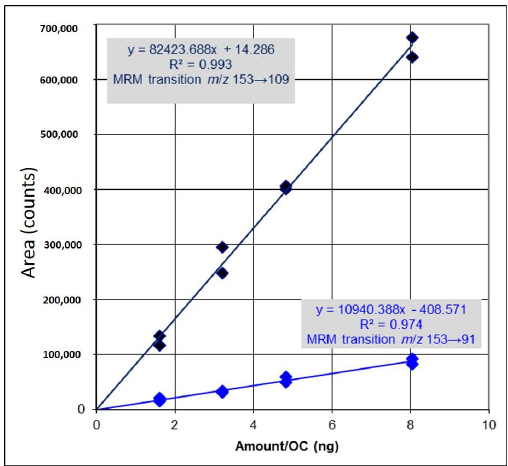
Figure 2. Calibration curve showing the quantification of protocatechuic acid (PCA) in Hibiscus sabdariffa water extract. An external calibration method with standard PCA (two MRM transitions m / z 153 → 109 and m / z 153 → 91) was used for quantification. OC: Amount (nanogram) in-column.